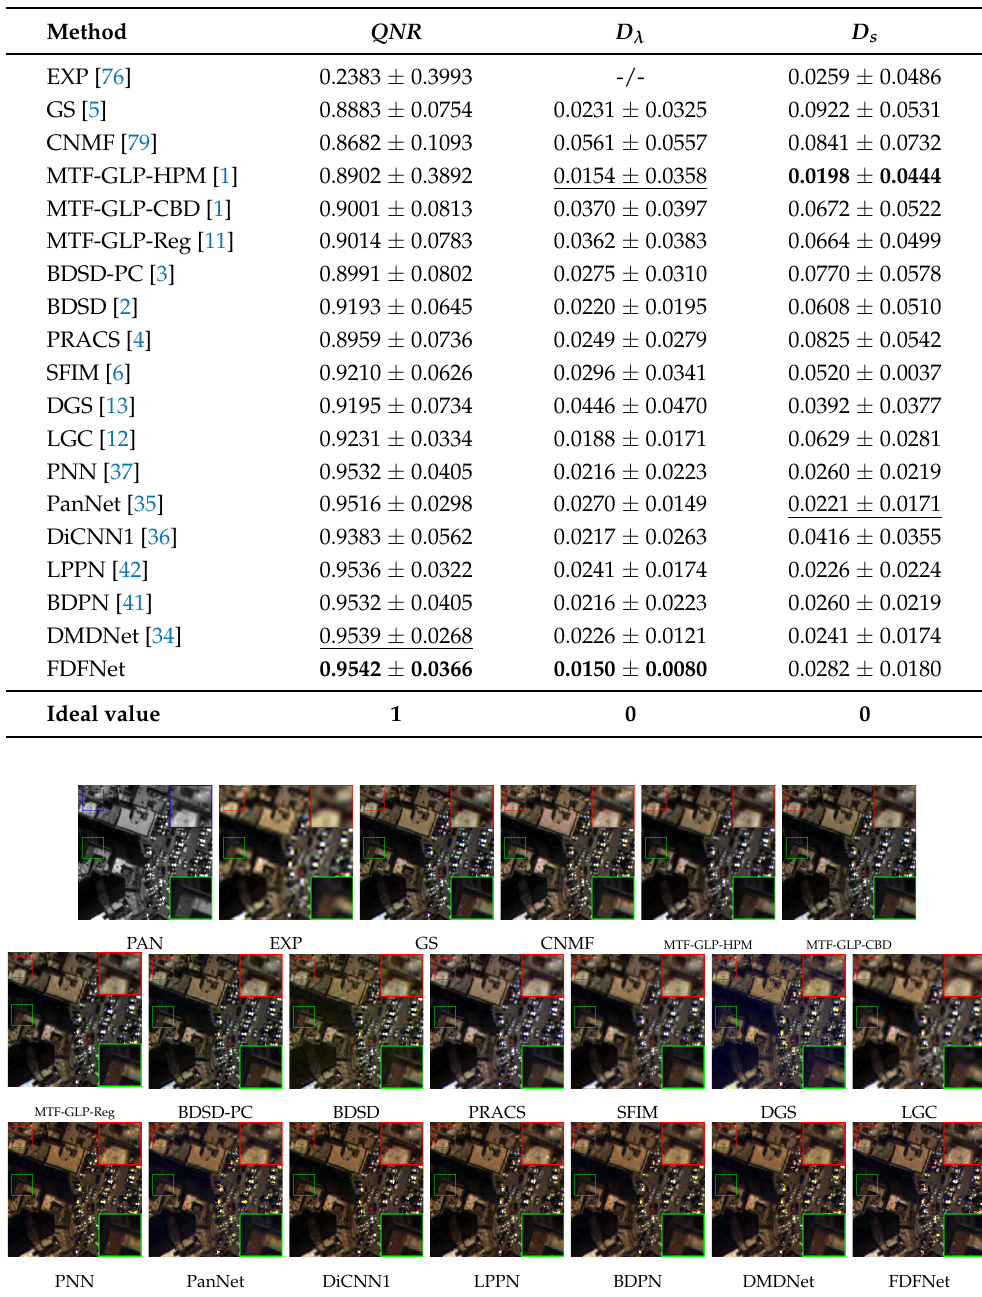
Figure 11. The visual comparisons on a full-resolution WorldView-3 case (shown by bands: 1, 3, and